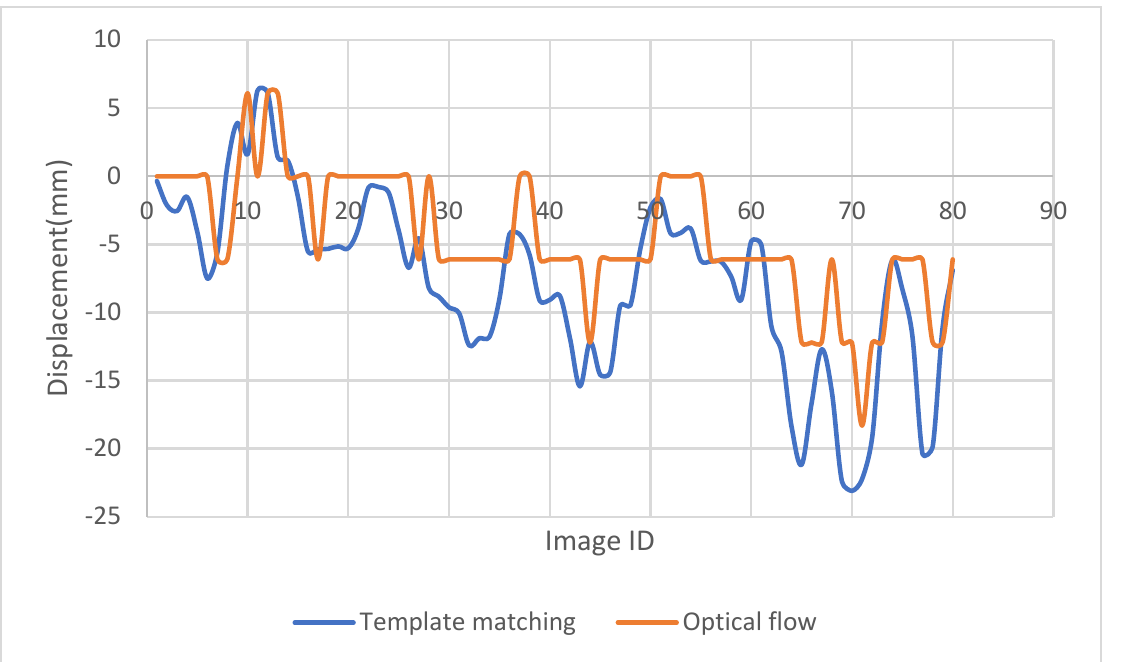
Figure 12. Y-displacement of the solar frame detected using the modi fi ed LK optical fl ow method and template matching.